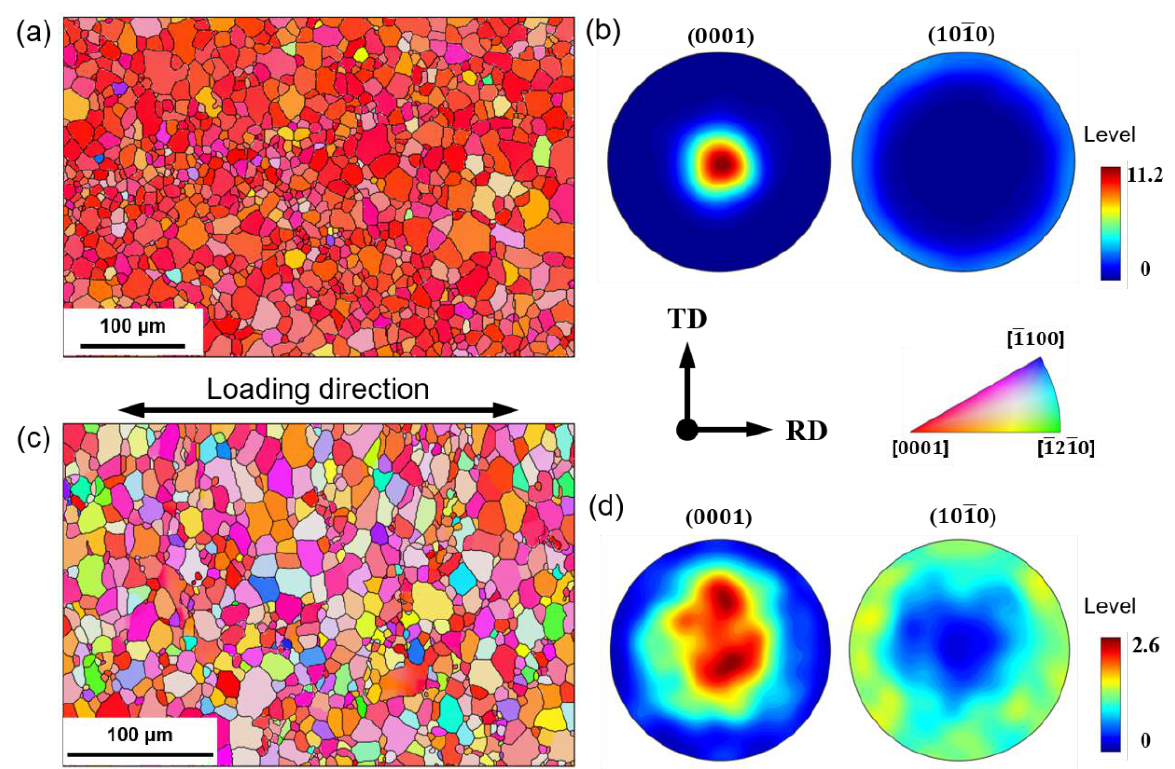
Figure 2. The inverse pole figure maps and pole figures of ( a , b ) the AZ31 alloy and ( c , d ) the WE43 alloy before deformation. The IPFs map shows that both ( a ) AZ31 and ( c ) WE43 alloys possessed uniform and equiaxed microstructures without any twins. ( b ) The PF map of the AZ31 alloy demonstrated that it has a strong (0001) basal texture with the max intensity of 11.2. ( d ) The PF map of the WE43 alloy showed more weakened basal texture compared with the AZ31 alloy, with the max intensity of 2.6.